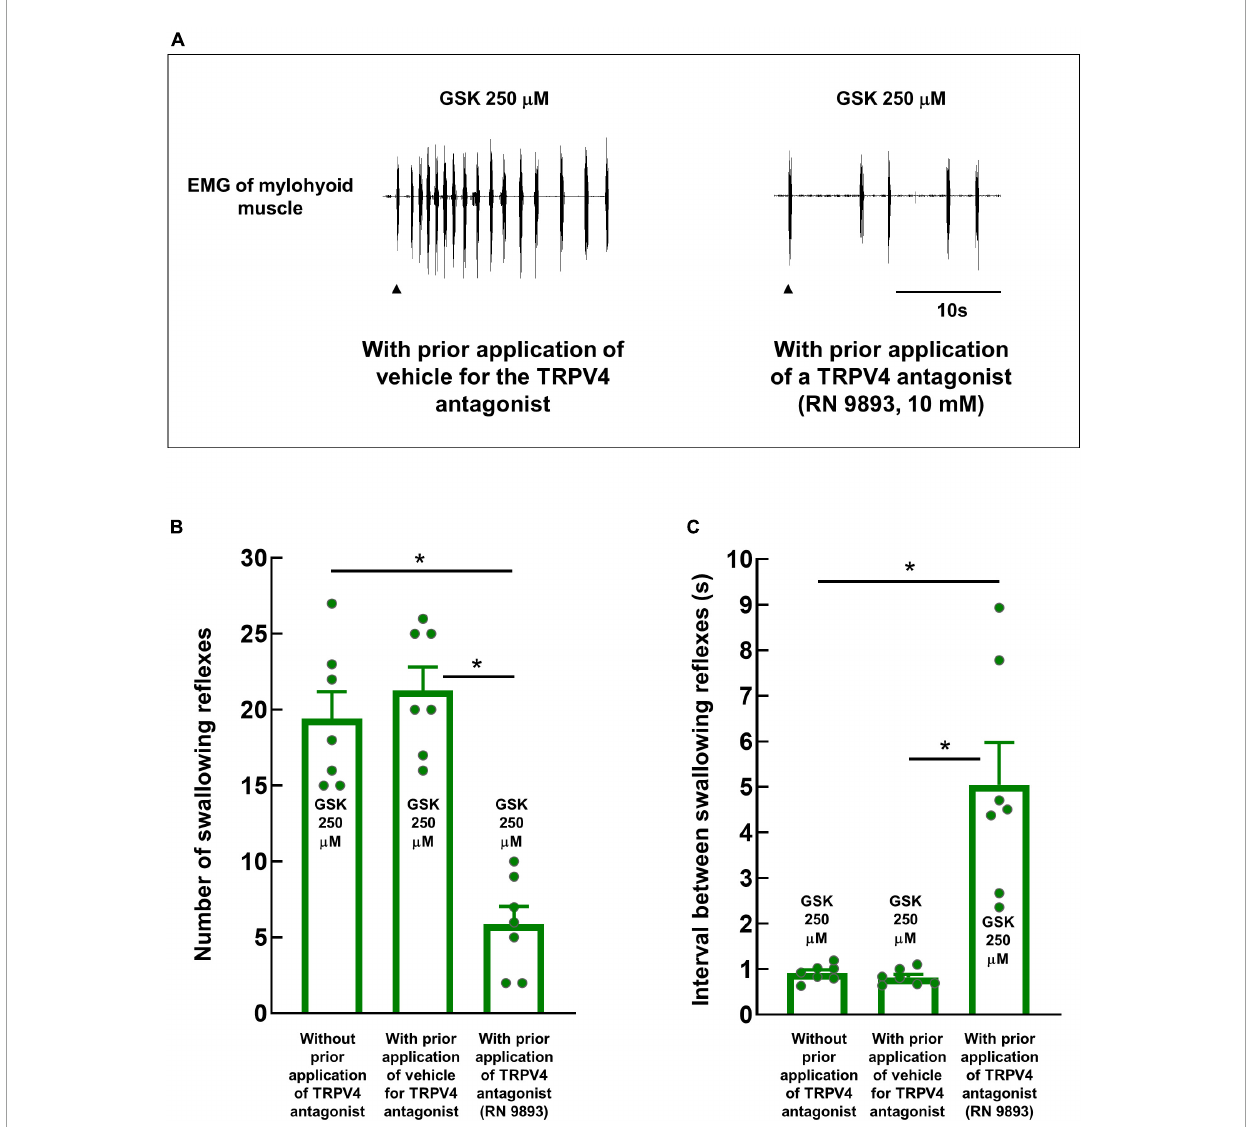
FIGURE5 Topical application of RN-9893, a TRPV4 antagonist, prior to the application of GSK1016790A, significantly reduced the number of GSK1016790A-triggered swallowing reflexes. (A) Swallowing reflexes triggered by GSK1016790A 250 µ M with prior topical application of the TRPV4 antagonist or vehicle. Black arrowheads indicate the onset of stimulating solution delivery. (B) Comparison of the numbers of swallowing reflexes triggered by GSK1016790A 250 µ M with and without prior application of the TRPV4 antagonist or vehicle. * P < 0.05 ( F = 34.76) by one-way repeated measures ANOVA followed by Tukey’s test. (C) Comparison of intervals between swallowing reflexes triggered by GSK1016790A with and without prior application of the TRPV4 antagonist or vehicle. * P < 0.05 ( F = 20.38) by one-way repeated measures ANOVA followed by Tukey’s test. n = 7. The number of triggered swallowing reflexes was counted for 20 s following application of the stimulating solutions, and the intervals between the swallowing reflexes were calculated from the reflexes evoked within the 10 s following the onset of solution delivery. Data are presented as the mean ± SEM. Circles in the column graph represent individual data points. * P < 0.05 by one-way repeated measures ANOVA followed by Tukey’s test. S,